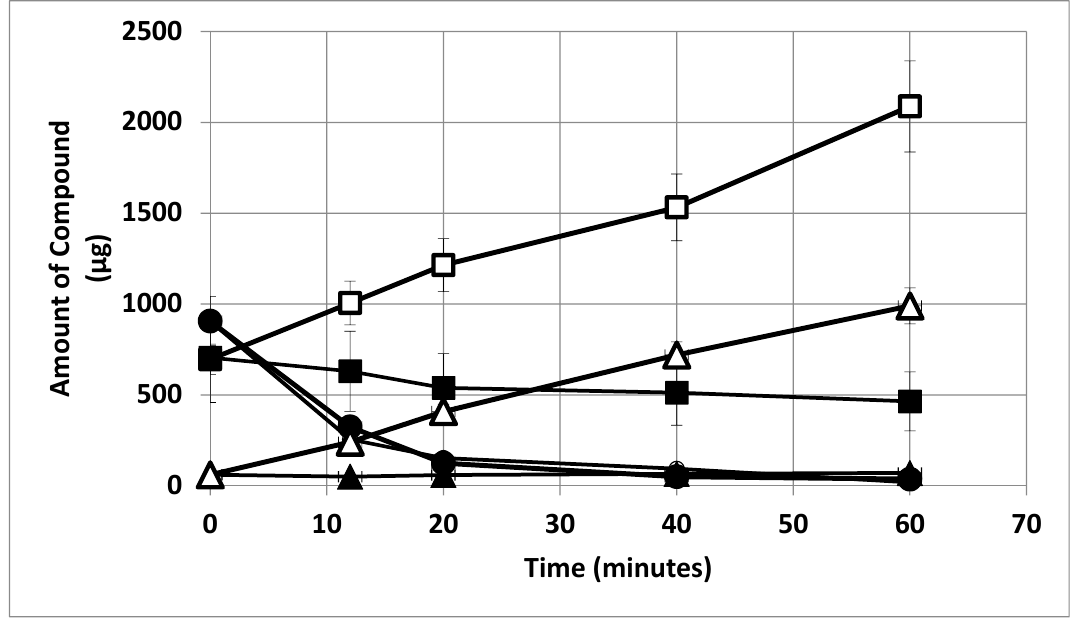
Figure 4. Effect of malate on alanine excretion, ammonium excretion and glutamate uptake by ex planta B . diazoefficiens bacteroids. Ammonium in the absence of L -malate, open squares; ammonium in the presence of 2 mM L -malate, closed squares; glutamate in the absence or presence of 2 mM L -malate, open and closed circles; alanine in the presence of 2mM L -malate, open triangles; and alanine in the absence of 2 mM L -malate or presence of 2 mM D -malate, closed triangles. Note the symbols for glutamate in the absence or presence of malate overlap. Assays were performed as described in Section 4 and contained 19.1 mg bacteroid dry weight and 0.008 atm partial pressure of oxygen. The values are the means of six measurements plus the range.